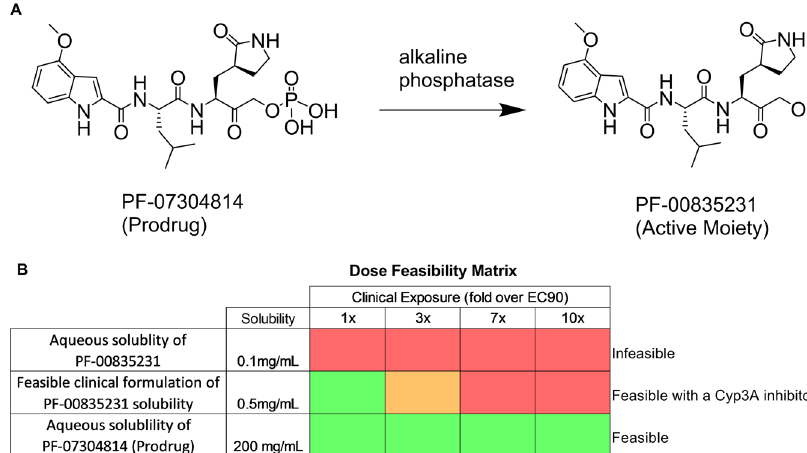
Fig. 5 PF-07304814 prodrug and PF-00835231 structures and dose considerations. A Chemical structure of conversion of prodrug PF-07304814 to the active moiety PF-00835231 by alkaline phosphatase. B Dose feasibility matrix illustrating the ability to achieve higher target exposures with increasing solubility and the limitations of dosing PF-00835231. with dosing either aqueous PF-00835231, clinically formulated PF-00835231, or aqueous PF- 07304814 (prodrug). The infeasible limit (red) is assumed to be 1 L per day with a 2x potential bene fi t with a Cyp inhibitor (orange). Any dose under that is considered feasible